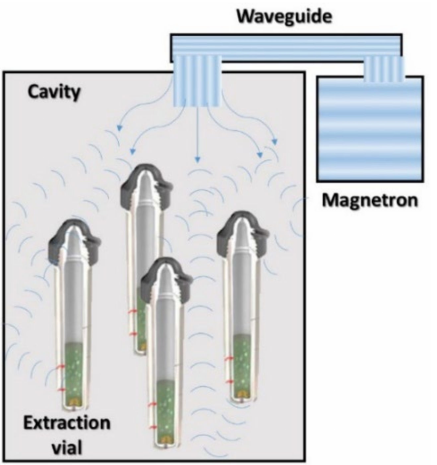
Figure 3. Diagram of a microwave-assisted